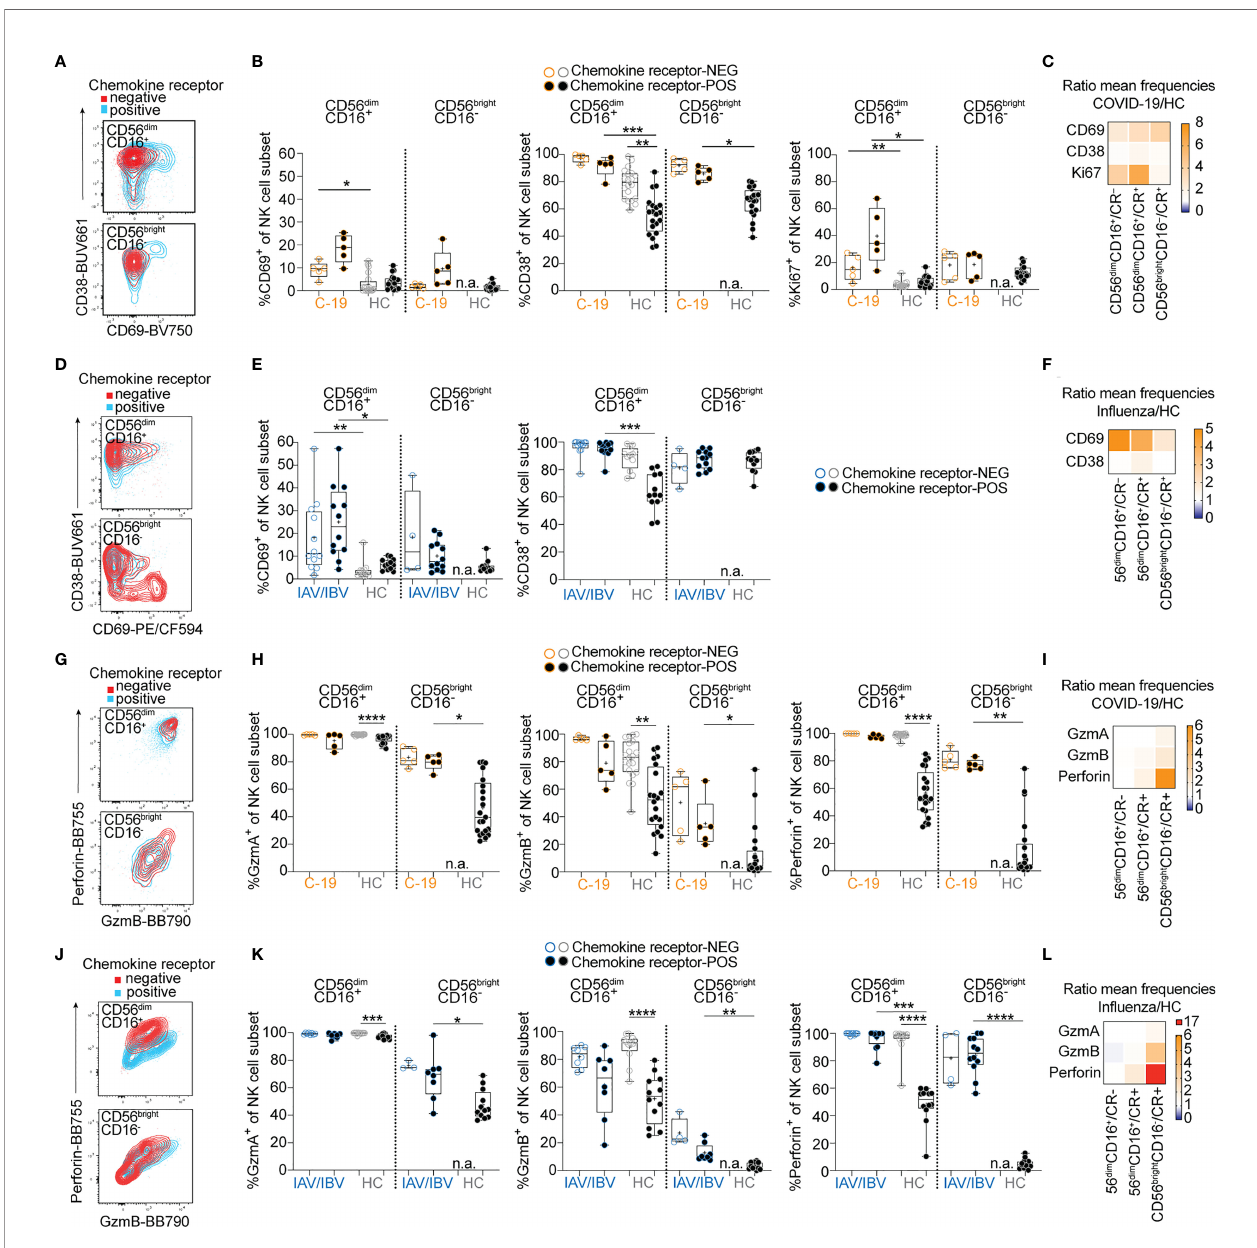
FIGURE 2 | Lung-homing receptor-positive NK cells display an activated phenotype in peripheral blood of COVID-19 and in fl uenza patients. Chemokine receptor- positive cells in COVID-19 and in fl uenza patients were identi fi ed using the Boolean gate “ CXCR3 + OR CXCR6 + OR CCR2 + OR CCR5 + ” ( ‘ CR+ ’ ; see representative gates in Figure S1B ). Cells lacking all of these receptors were identi fi ed as chemokine receptor-negative (CR – ). (A) Representative overlays and (B) summary of data showing CD69, CD38 and Ki67 expression on chemokine receptor-negative (open circles) and chemokine receptor-positive (closed circles) CD56 dim CD16 + and CD56 bright CD16 - blood NK cells from COVID-19 patients (orange, n = 5-10) and healthy controls (grey, n = 20). (C, F) Heatmaps displaying the ratio of mean expression of (C) CD69, CD38, and Ki67 between COVID-19 patients and healthy controls or (F) of CD69 and CD38 between in fl uenza patients and healthy controls in CR - and CR + CD56 dim CD16 + and CR + CD56 bright CD16- NK cells. Baseline value = 1 (white). (D) Representative overlays and (E) summary of data of CD69 and CD38 expression on CR + and CR – CD56 dim CD16 + and CD56 bright CD16 - blood NK cells from in fl uenza patients ( n = 4-12) and healthy controls (grey, n = 12), respectively. (G) representative dot plots and (H) summary of data showing granzyme A, granzyme B and perforin expression on chemokine receptor- negative and -positive CD56 dim CD16 + and CD56 bright CD16 - blood NK cells from COVID-19 patients ( n = 5-10) and healthy controls ( n = 20). (I, L) Heatmaps displaying the ratio of mean expression of (I) granzyme A, granzyme B and perforin between COVID-19 patients and healthy controls or (L) between in fl uenza patients and healthy controls in CR - and CR + CD56 dim CD16 + and CR + CD56 bright CD16- NK cells. Baseline value = 1 (white). (J) Representative overlays and (K) summary of data of granzyme A, granzyme B, and perforin expression on chemokine receptor-negative and -positive CD56 dim CD16 + and CD56 bright CD16 - blood NK cells from in fl uenza patients ( n = 4-12) and healthy controls ( n = 12), respectively. (B, E, H, K) Box and Whiskers, min to max, mean shown as ‘ + ’ . Kruskal-Wallis rank-sum test with Dunn ’ s post hoc test for multiple comparisons. *p < 0.05, **p < 0.01, ***p < 0.001, ****p <